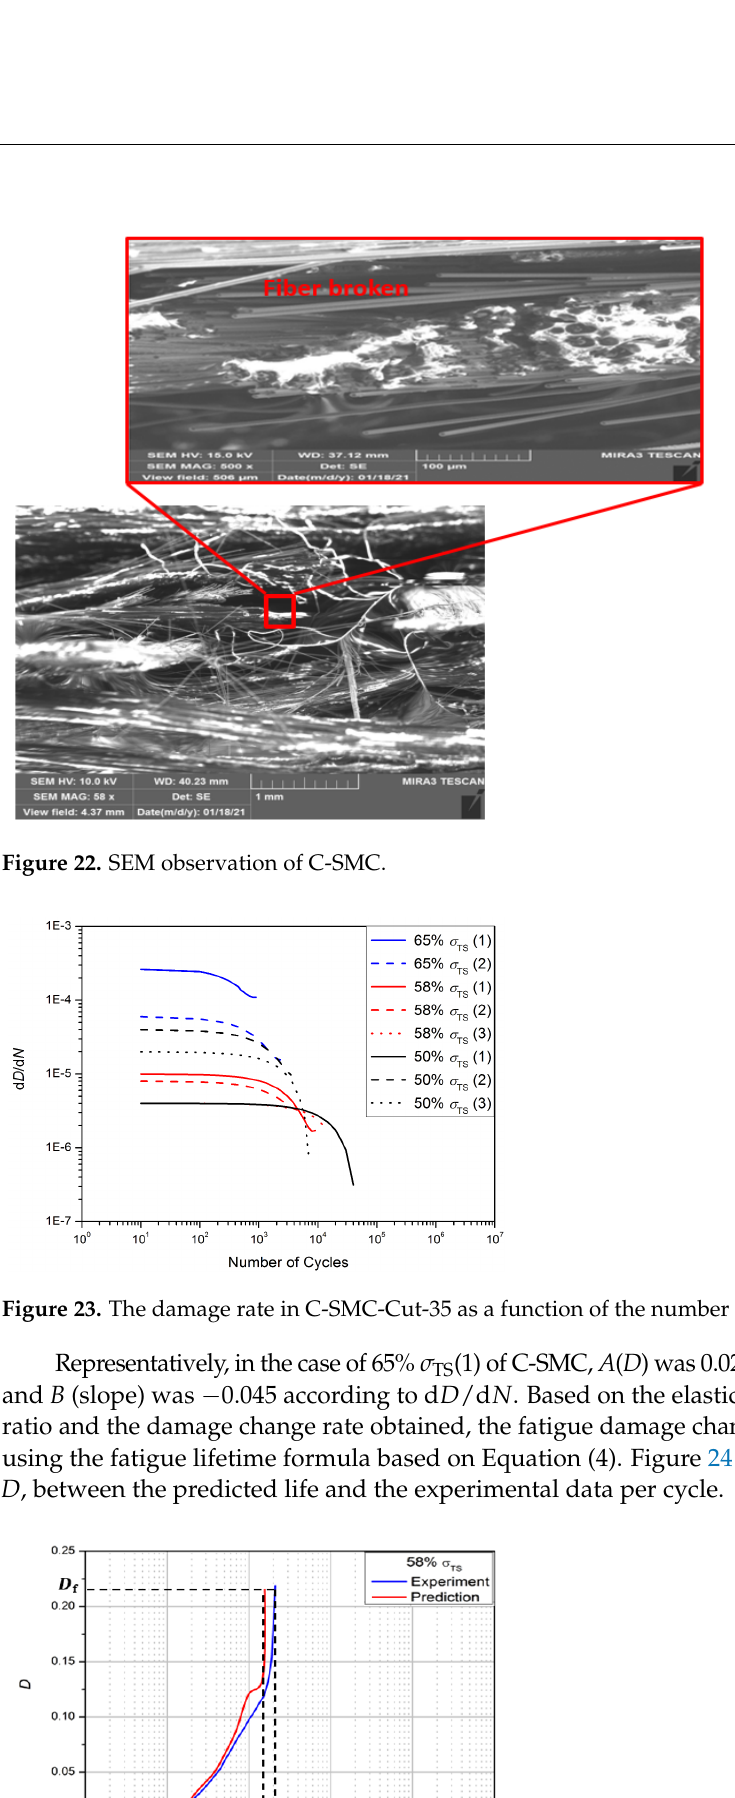
Figure 24. Validation of suggested damage model for C-SMC-Cut-35 in comparison to experiment. Here, (cid:1830) (cid:2916) is the elastic modulus based on the fracture criterion, (cid:1840) (cid:2900)(cid:2928)(cid:2915) is the number of predicted load cycles and (cid:1840) (cid:2889)(cid:2934)(cid:2926) is the number of load cycles at the fatigue fracture from the experiment. Figure 25 shows that the fatigue life prediction results based on the elastic modulus degradation and the fatigue life curve from the actual test exhibited an excellent correlation. The error between the experiments and the estimation result based on the elastic modulus degradation was verified to be within 3%. Therefore, it is reasonable that the fatigue life estimation based on the fatigue damage rate is a viable alternative for esti- mating the fatigue life of C-SMC based on the cyclic stress–strain curves. Furthermore, the fatigue life estimation can predict the S–N curve without a lot of fatigue tests.